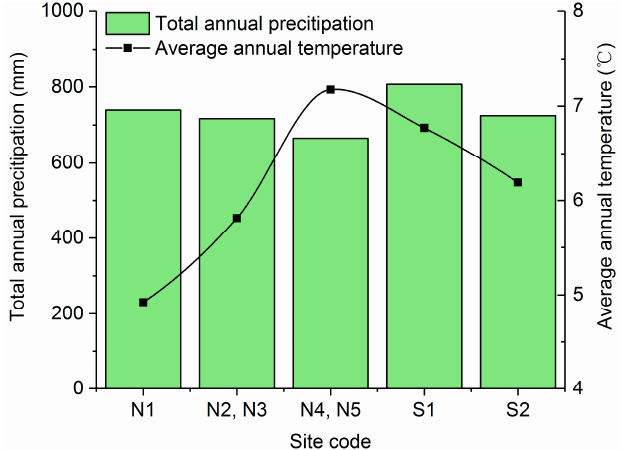
Figure 2. Total annual precipitation and average annual temperature in seven sampling sites in the alpine treeline ecotone in the eastern Tibetan Plateau during the period of 1971–2014. The meteorological data were acquired from a gridded CRU dataset (Climate Research Unit, 3.23 at 0.5° spatial resolutions, http://www.cru.uea.ac.uk/data/). Note the left y-axis is for precipitation and the right y-axis is for temperature.